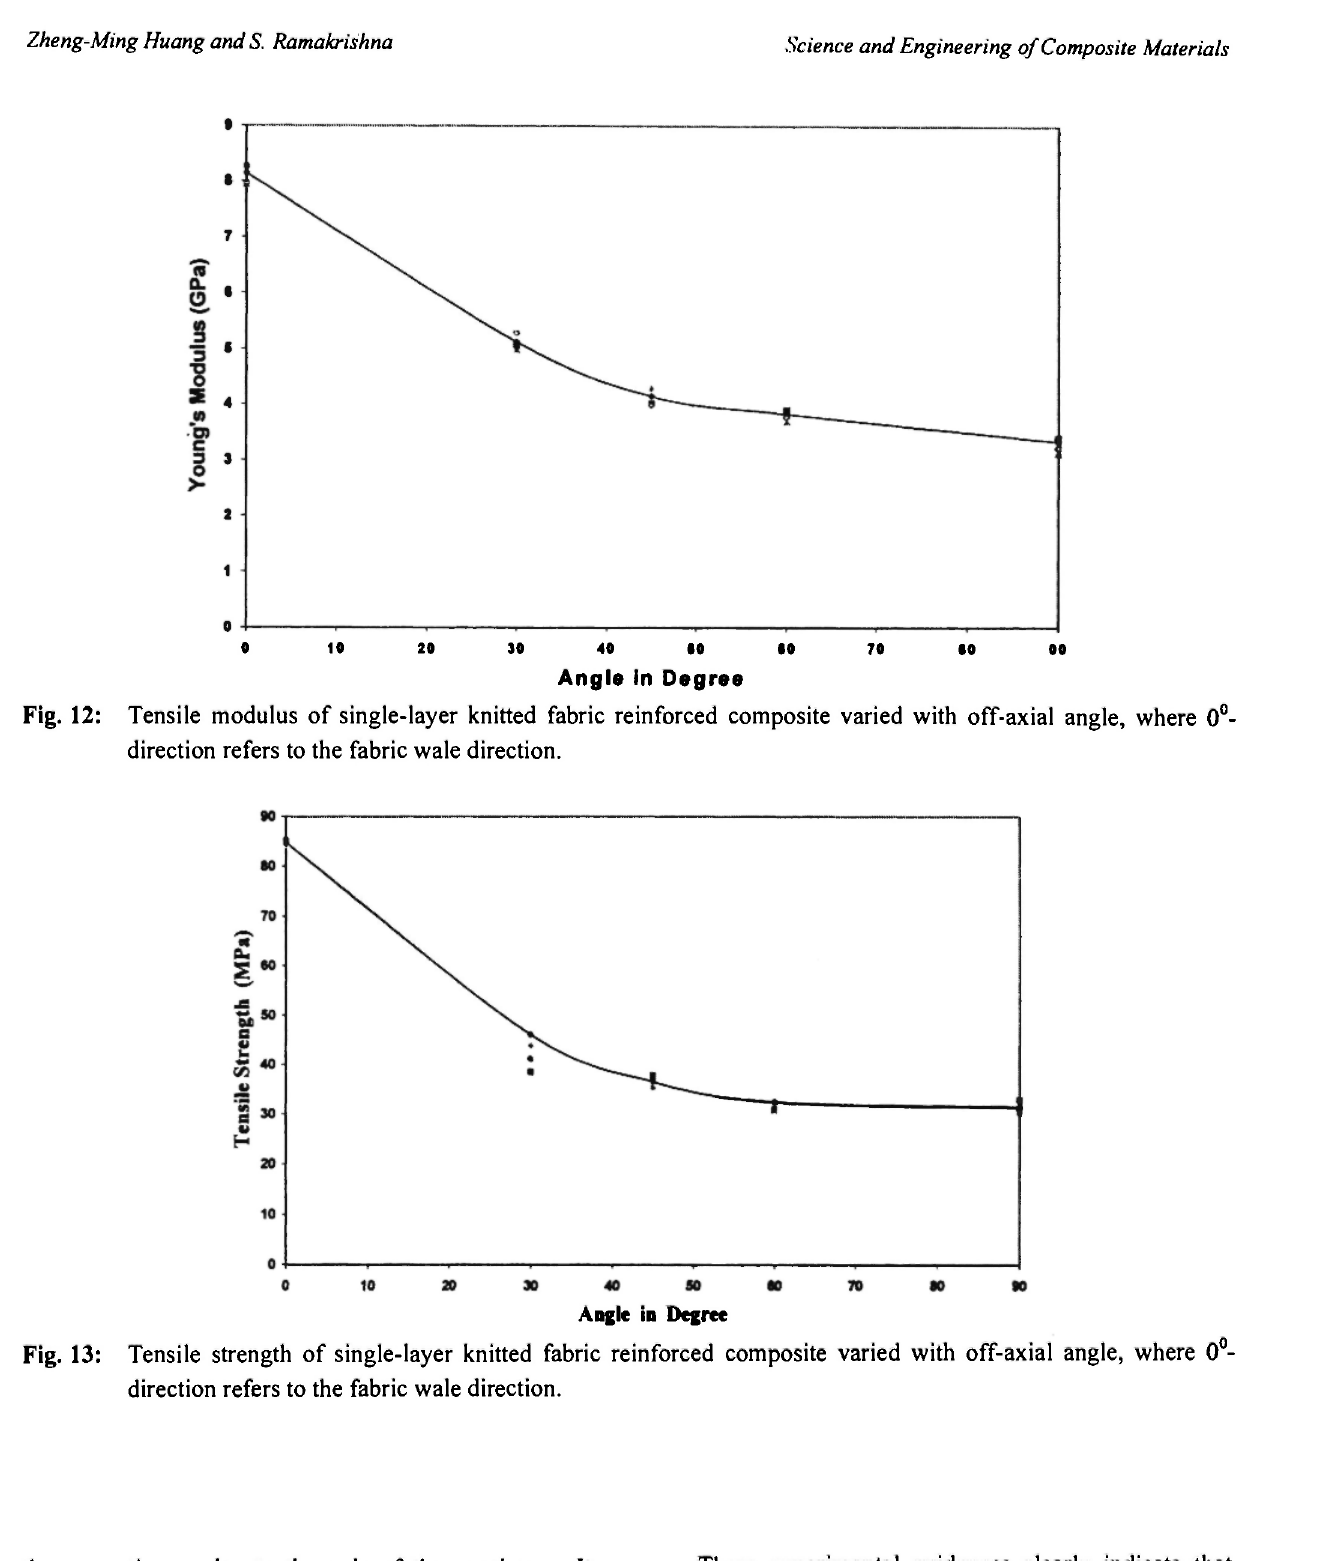
the respective angles to the axis of the specimens. It seems that except for the 0° (wale) directional specimen, all the other off-axial specimens fractured due to a tensile stress component perpendicular to the wale